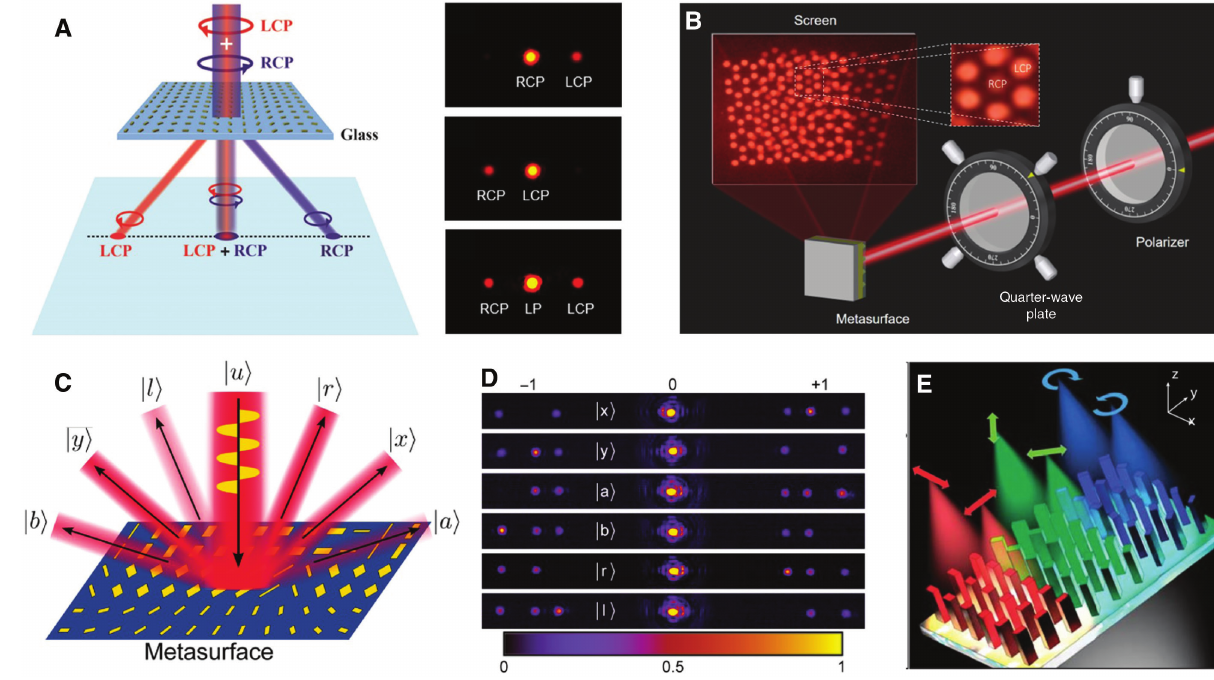
Figure 1: Optical metasurfaces for polarization measurement. (A) Left: schematic to show the polarization of the refracted light after a completely polarized light beam passing through the metasurface. Right: experimental results of the refracted light spots on the transmission side of the metasurface for incident light with